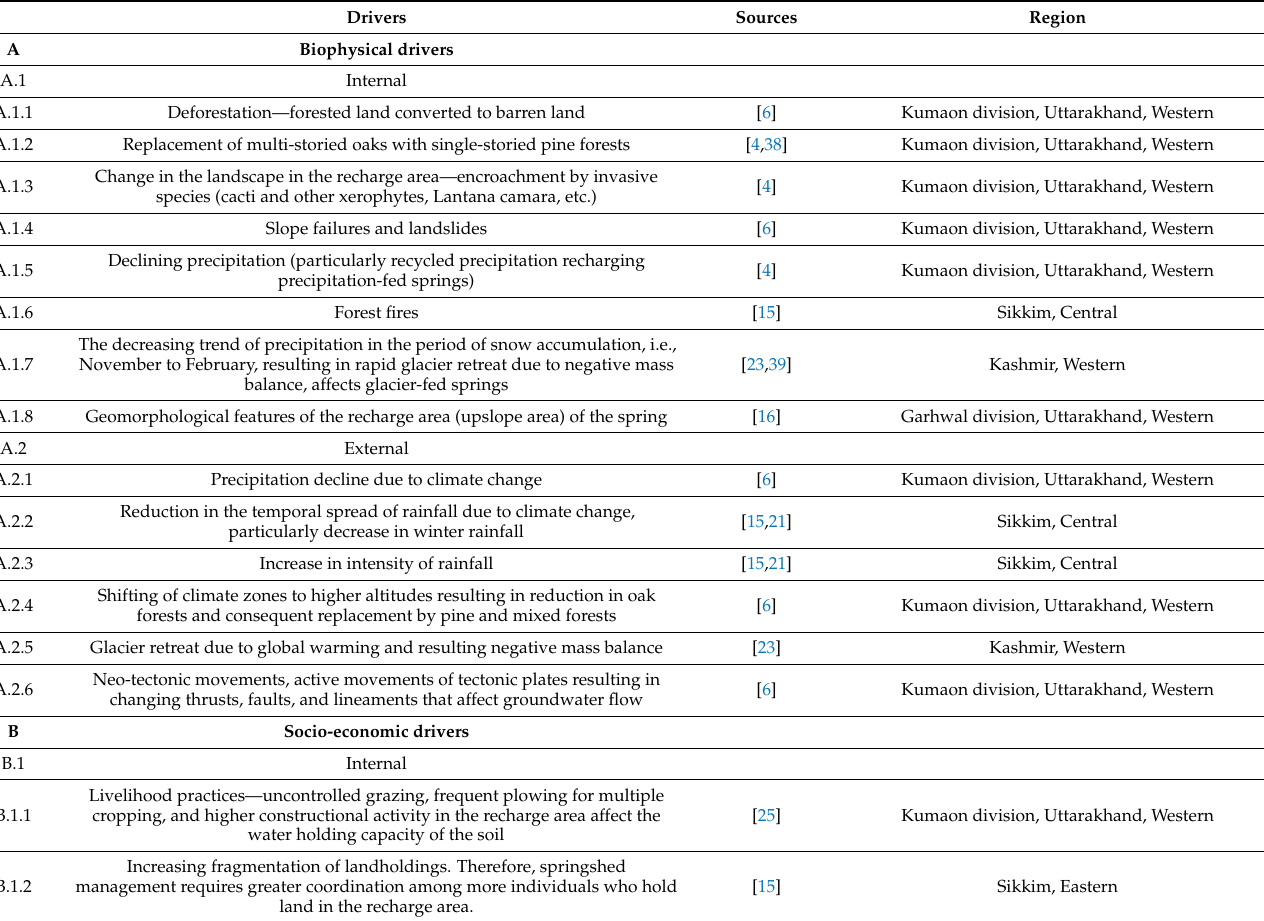
Table 2. Synthesis of drivers of change in the Indian Himalayas.